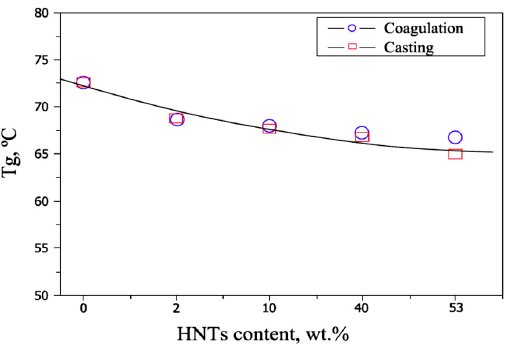
Figure 10. T g curves of PVA-HNT composites with different HNT contents [3].